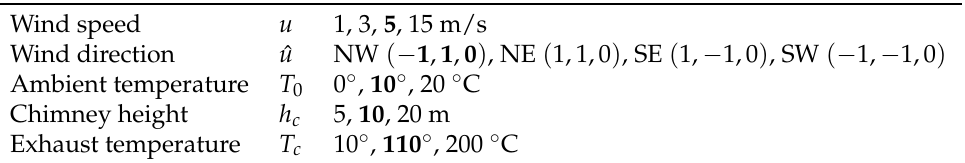
Table 3. Simulation parameters. The parameters of the studies and their values are given. The highlighted values are the parameter values for the reference